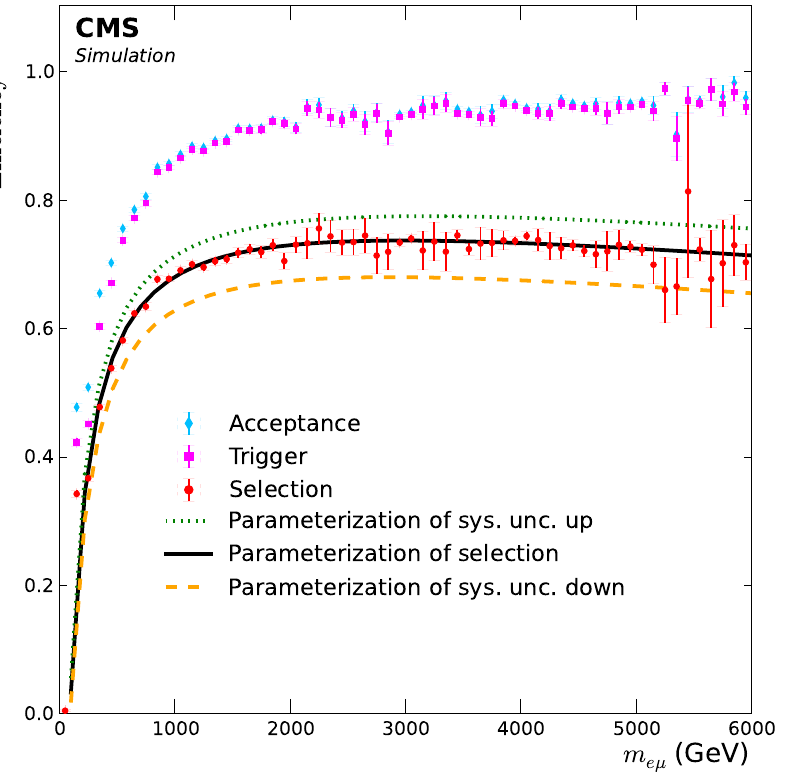
Figure 7 . E(cid:14)ciency of the RPV signal for all events after the acceptance requirements (light blue triangular points), after acceptance and trigger requirements (magenta square points), and after the full selection, which includes acceptance and trigger criteria (red round points). The reconstruction e(cid:14)ciency is also included, with the product of the (cid:12)nal acceptance and e(cid:14)ciency parametrized for the statistical interpretation by a function illustrated by the black line. The systematic uncertainties are obtained by propagating the e(cid:11)ect of the systematic uncertainties to the e(cid:14)ciency. The systematically shifted upper and lower e(cid:14)ciency points are not shown in the (cid:12)gure, but just the parametrization of both dependencies, with upward shifts in dotted green and downward shifts in dashed orange.